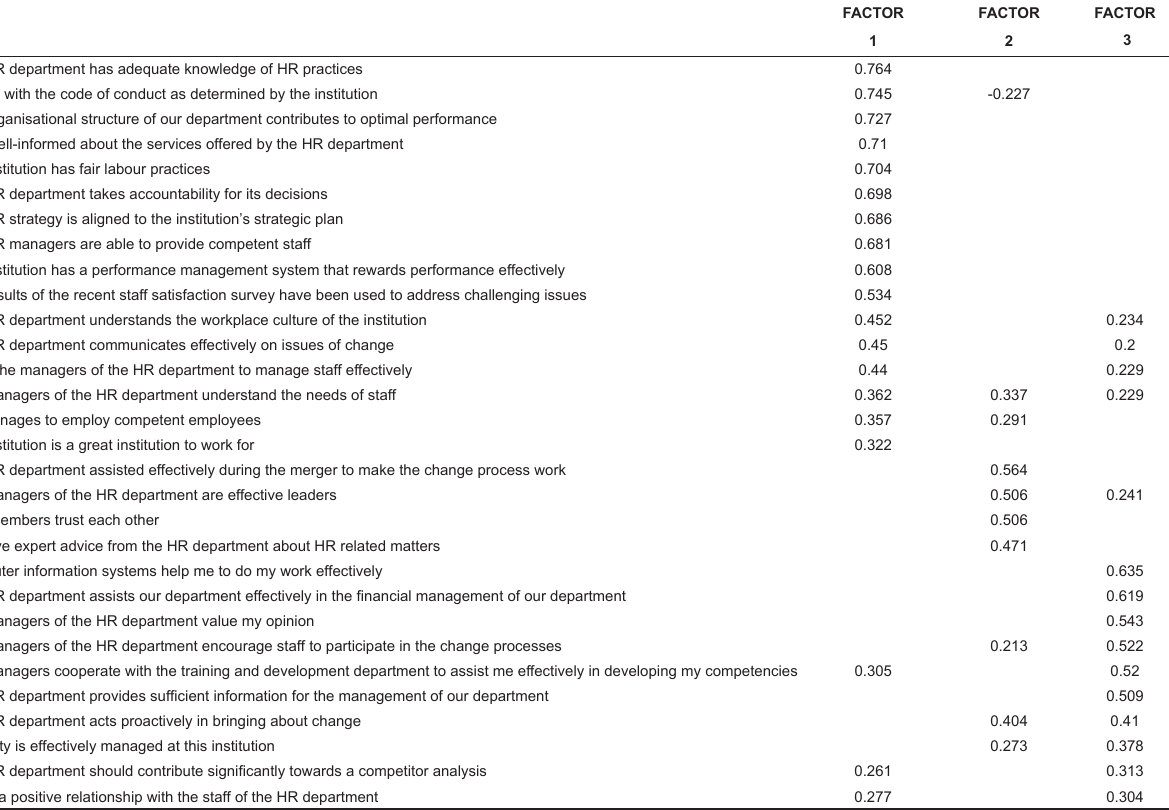
TABLE 4 Three-factor analysis results of the principal axis factor analysis